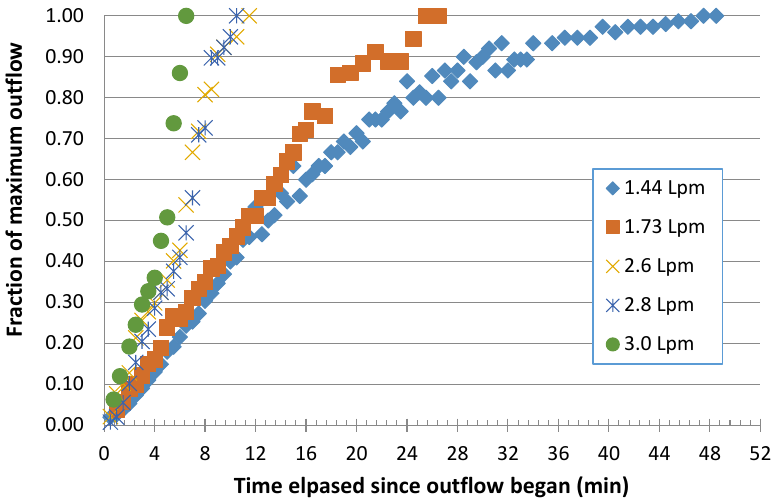
Figure 8. Sandbox subsurface outflow rate as it depends on elapsed time after beginning at 2 m downslope for bed slope of 51.8% and 143 mm depth sand.